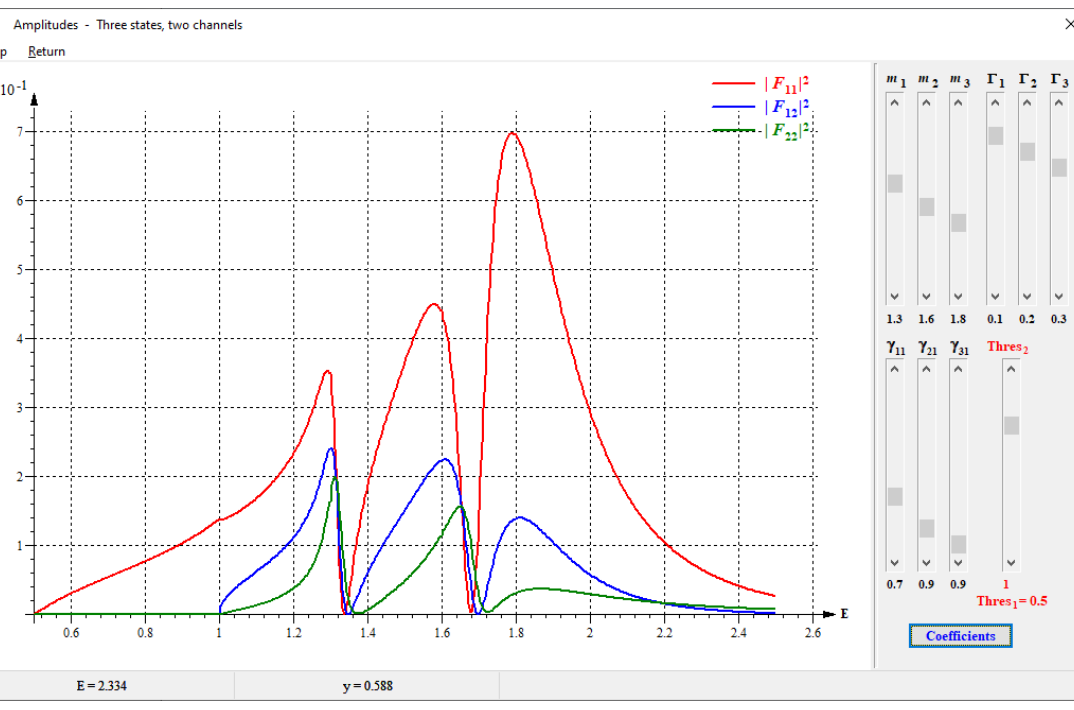
Figure A2. K-matrix scattering amplitudes. The parameters in the screenshot in Figure A2 are: 1